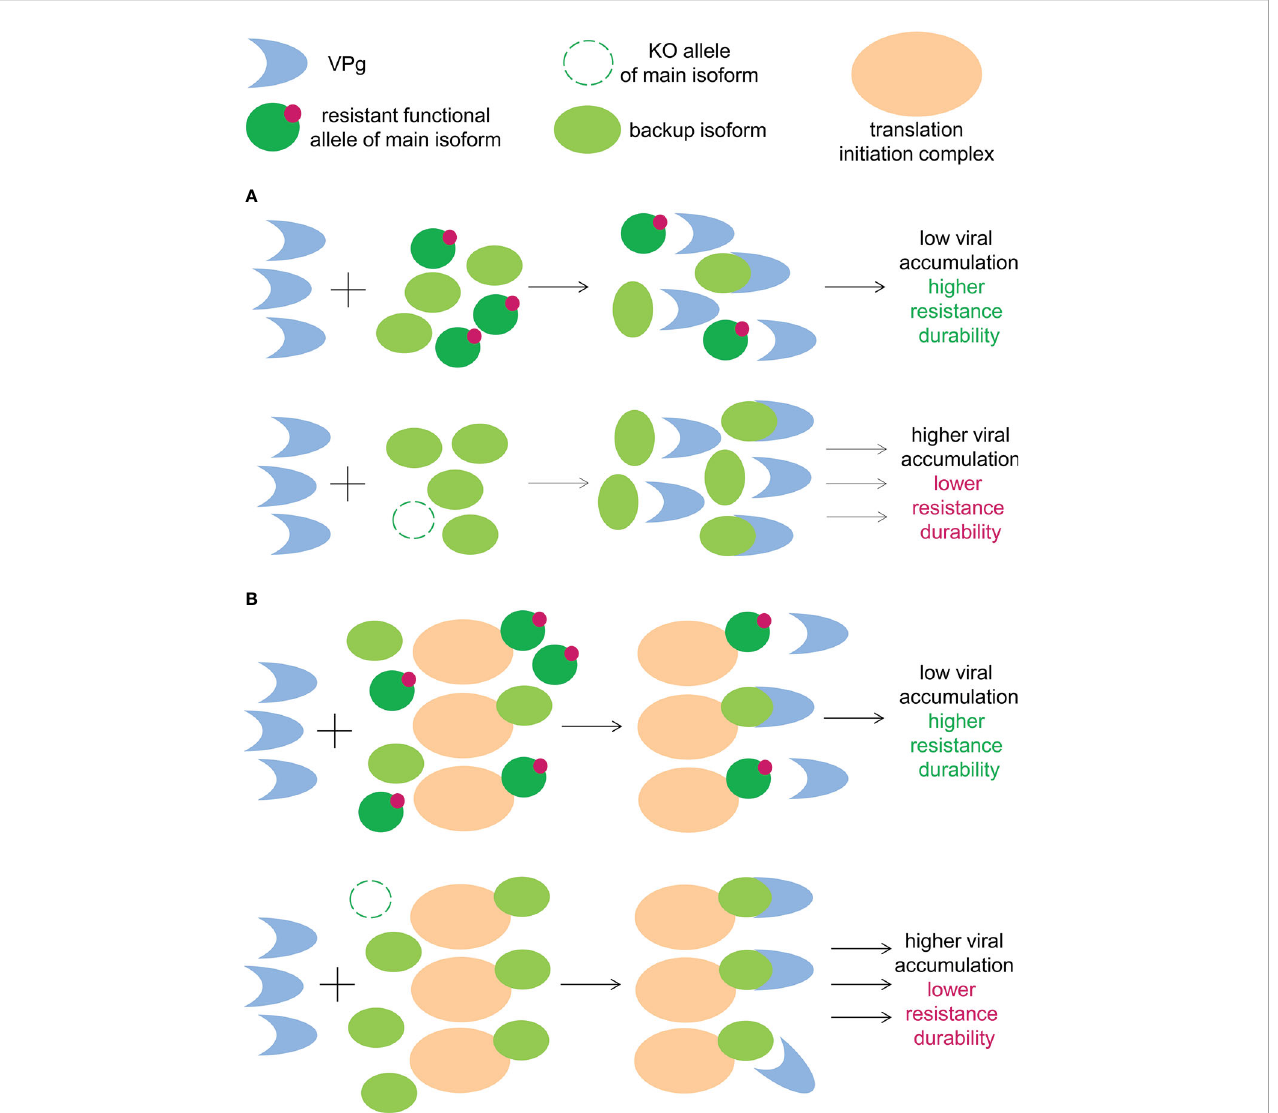
FIGURE 2 (A) Functional resistant allele of main eIF4E isoforms downregulates the cellular concentration of the backup eIF4E isoform, leading to reduced viral accumulation. (B) The functional resistant allele of the main eIF4E isoform competes with the backup eIF4E isoform for the cellular translation apparatus, leading to reduced viral